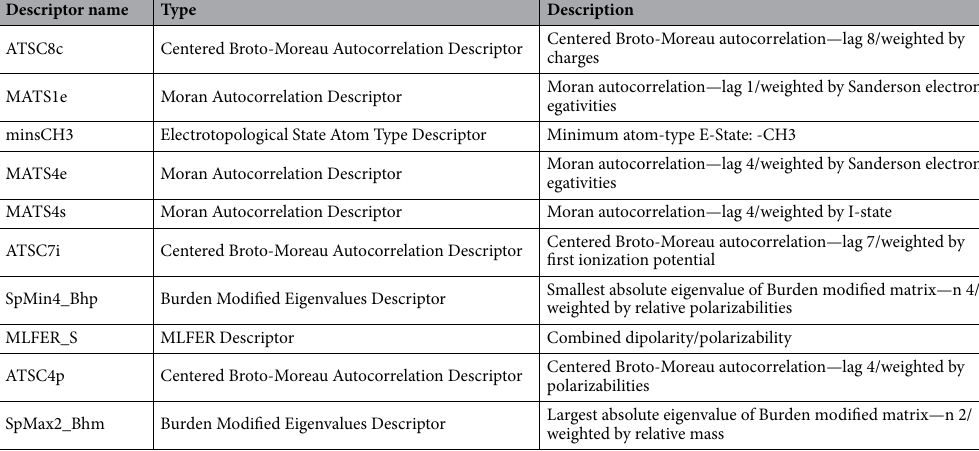
Table 8. Name, type, and description of selected 10 features determining the period changing information of a